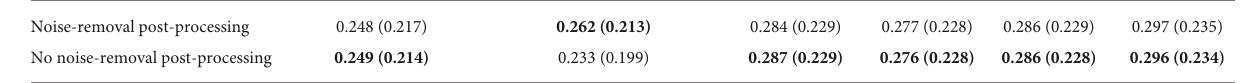
TABLE 2 Mean Dice value for each tissue outcome prediction method with and without applying additional filtering operations to each tissue outcome prediction for the purpose of noise reduction. Tmax thresholding Random decision forest Param-UNet RC-Simple RC-Causal CTC-Causal